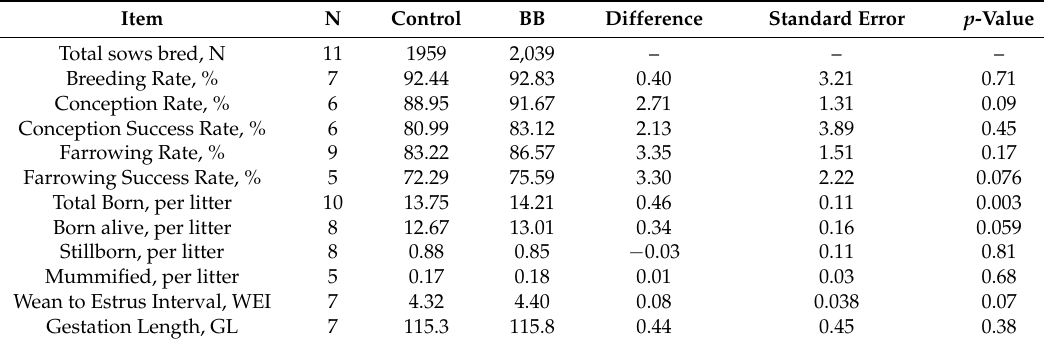
Table 2. Effects of a novel boar pheromone, BOARBETTER (BB) on measures of reproductive performance of sows 1 .